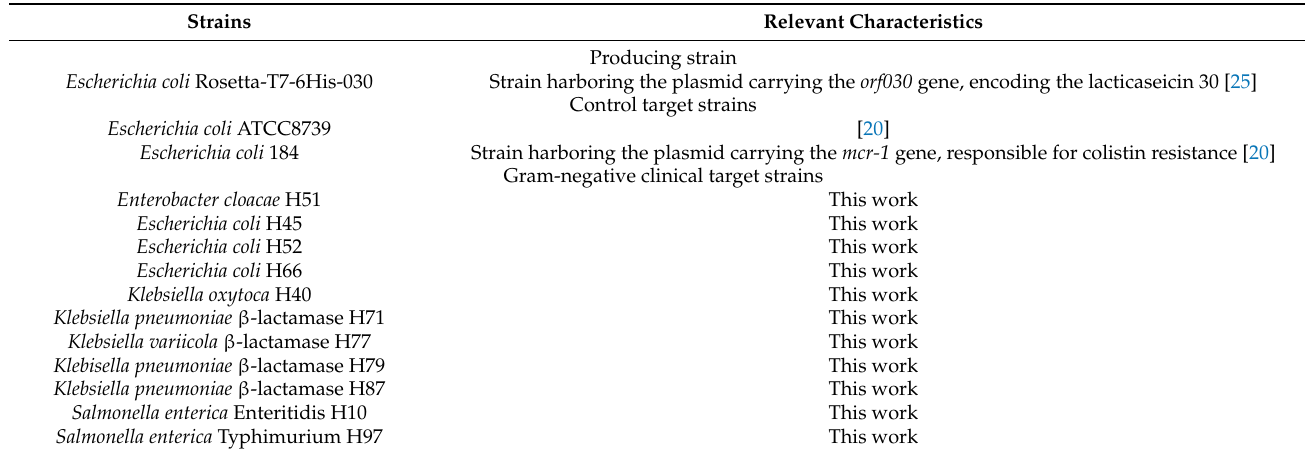
Table 3. Bacterial strains used in this